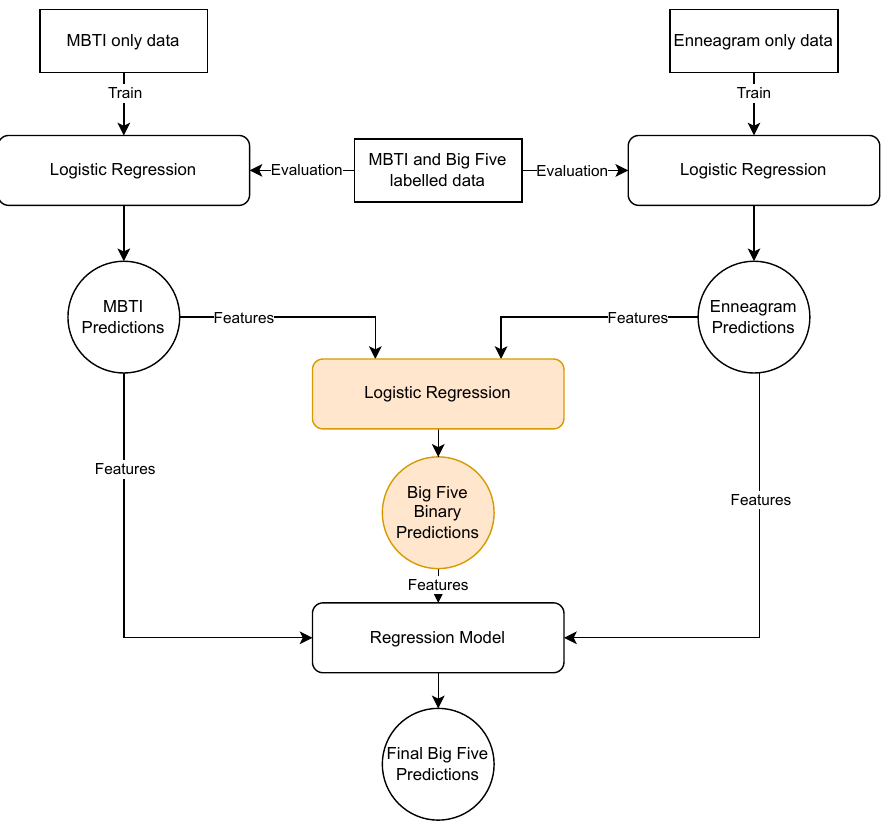
Figure 8. Illustration of the model stack after introducing the Big Five classification